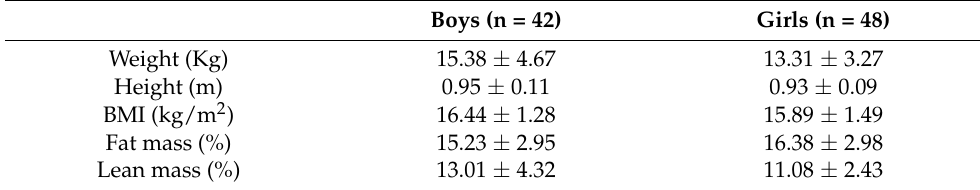
Table 4. Sample characteristics. Average age. 2.9 years.